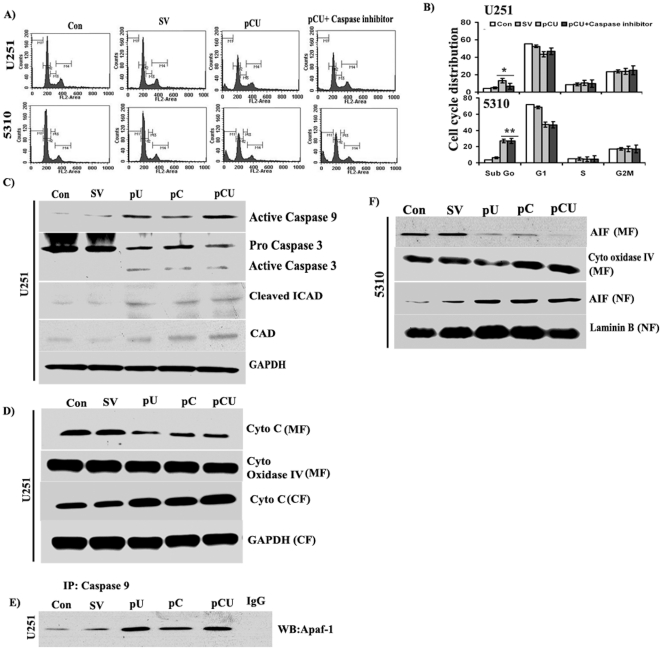
Downregulation of uPAR and cathepsin B induced caspase-dependent apoptosis in U251 cells and caspase-independent apoptosis in 5310 cells.(A) FACS analysis of pCU-transfected U251 and 5310 cells pretreated with 40 µM broad caspase inhibitor (Z-Asp-2, 6-dichlorobenzoylmethylketone). (B) Histograms represent the percentage of cells in G0/G1, S and G2/M phases. The data represent one of the three independent experiments. Values are mean ± SD of three different experiments (*p<0.05, **p<0.001). uPAR and cathepsin B downregulation induced activation of caspase-9, caspase-3, ICAD, CAD in pU-, pC- and pCU-treated U251 cells. (C) Western blot analysis for active caspase-9, caspase-3, ICAD and CAD in U251 cells. (D) Expression of cytochrome c in mitochondrial and cytosolic fractions was determined by western blot analysis. Cytochrome oxidase IV was used as a marker for mitochondrial fractions (MF); GAPDH was used for cytosolic fractions (CF). (E) Immunoprecipitation of Apaf-1 from U251 cell lysates. Total cell lysates were subjected to immunoprecipitation using anti-caspase-9 antibody and then immunoblotted for Apaf-1. Total lysates from SV-, pU-, pC- and pCU-treated U251 cells were separated into mitochondrial and nuclear fractions as per standard protocols and immunoblotted for AIF. (F) Expression levels of AIF in mitochondrial (MF) and nuclear fractions (NF) were determined by western blot analysis. Cytochrome oxidase IV was used as a marker for mitochondrial fractions; laminin B was used for nuclear fractions. Total lysates from SV-, pU-, pC- and pCU-treated 5310 cells were fractionated into mitochondrial and cytosolic fractions as per standard protocols and immunoblotted for cytochrome c. Immunoblots are representative of three experiments.